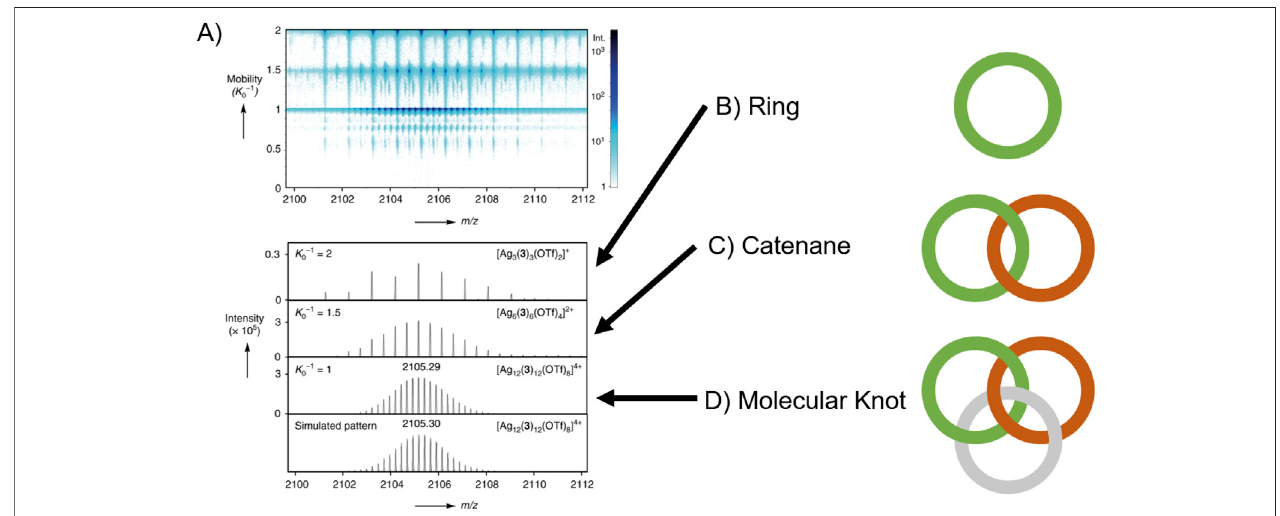
FIGURE 12 | The general concepts that separate (B) rings, (C) catenanes and (D) molecular knots is the number of rings and number of ring crossings. The separationofisobars (A) isasimplebut effective useofIMS-MStostudy catenanes andknots.Heretheseparationofacomplexmolecular knot isdistinguishedfromits component rings and catenanes also present in the reaction (Sawada et al., 2019).